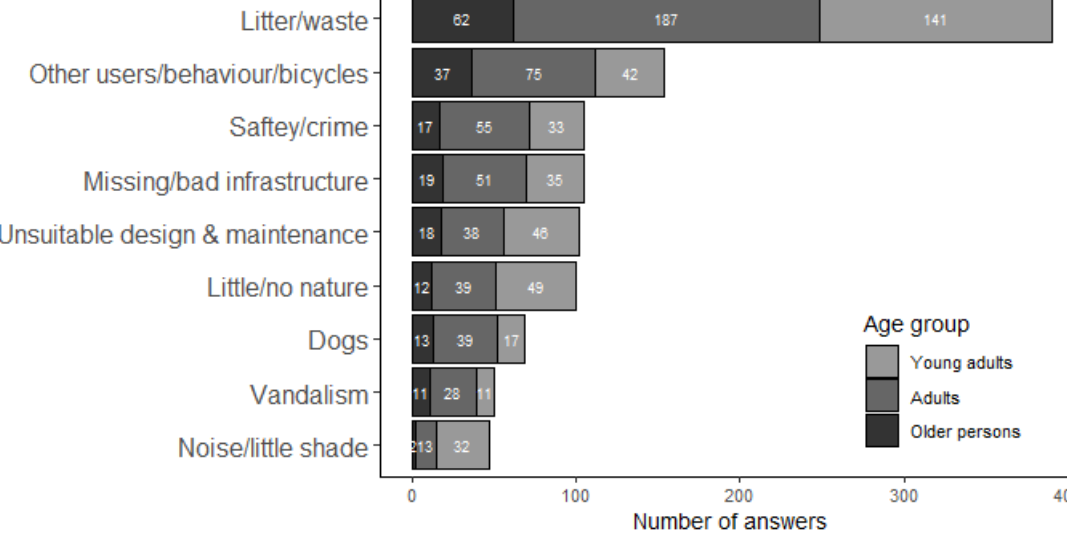
Figure A1.9: Frequencies of perceived disturbances/disservices (categorized answer from open question) in urban parks mentioned by respondents of different age groups in Leipzig. Multiple answers were possible. The white numbers display the number of answers for each age